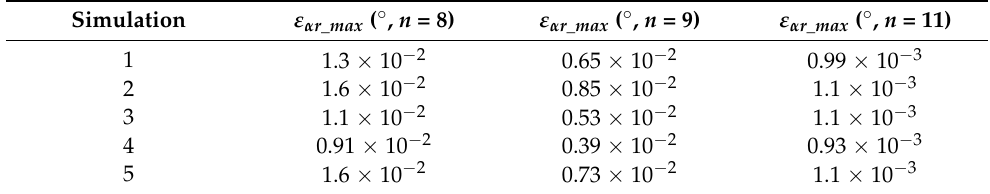
Table 6. Maximum polarization angle remaining fitting errors achieved for simulated 100 (second and third column) and 10,000 (fourth column) successive measurements. Five independent simulations were performed for each number of terms ( n